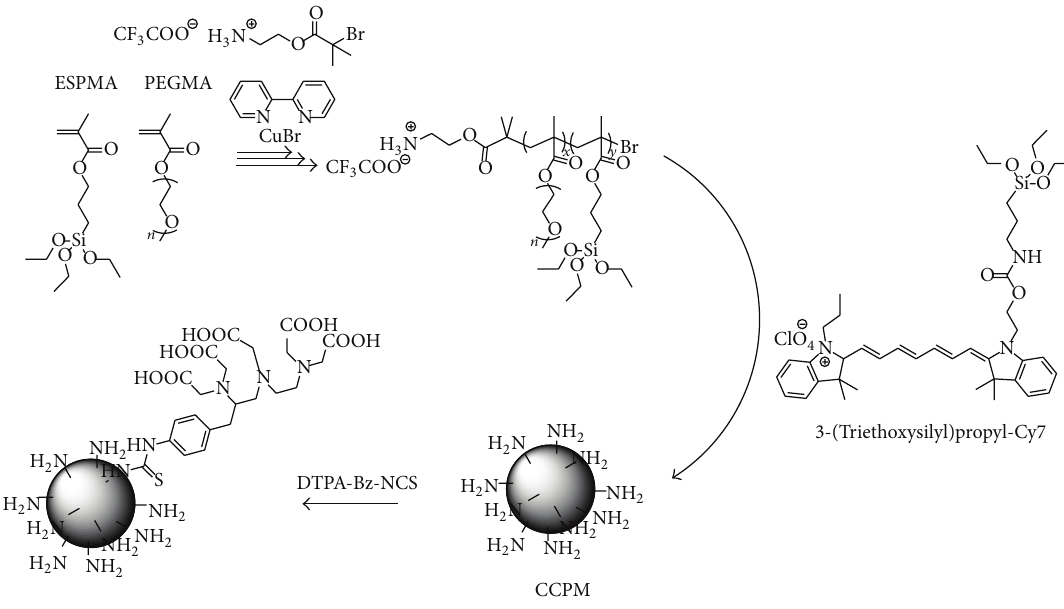
Figure 3: Preparation of core-cross-linked polymeric micelle